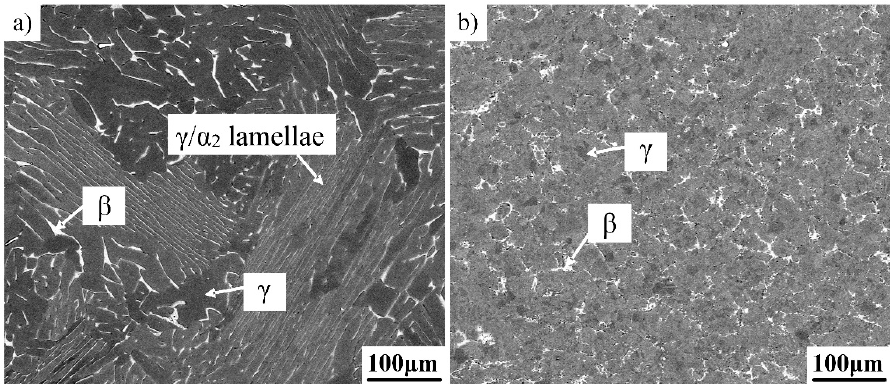
Figure 1. Initial microstructures of the Ti–43Al–2Cr–2Mn–0.2Y alloy. ( a ) As-cast, ( b ) as-forged.